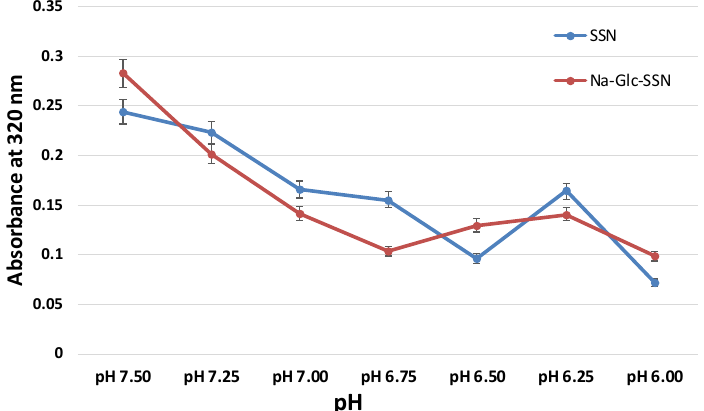
Figure 9. Acid dissolution profiles of SSNs, prepared by adding SrCl 2 (60 mM) and Na 2 SO 3 (10 mM) and Na-Glc-SSNs, prepared by adding 60 mM of SrCl 2 , 300 mM of NaCl, 200 mM of glucose and 10 mM of Na 2 SO 3 , in a 50 µL of an aqueous solution.